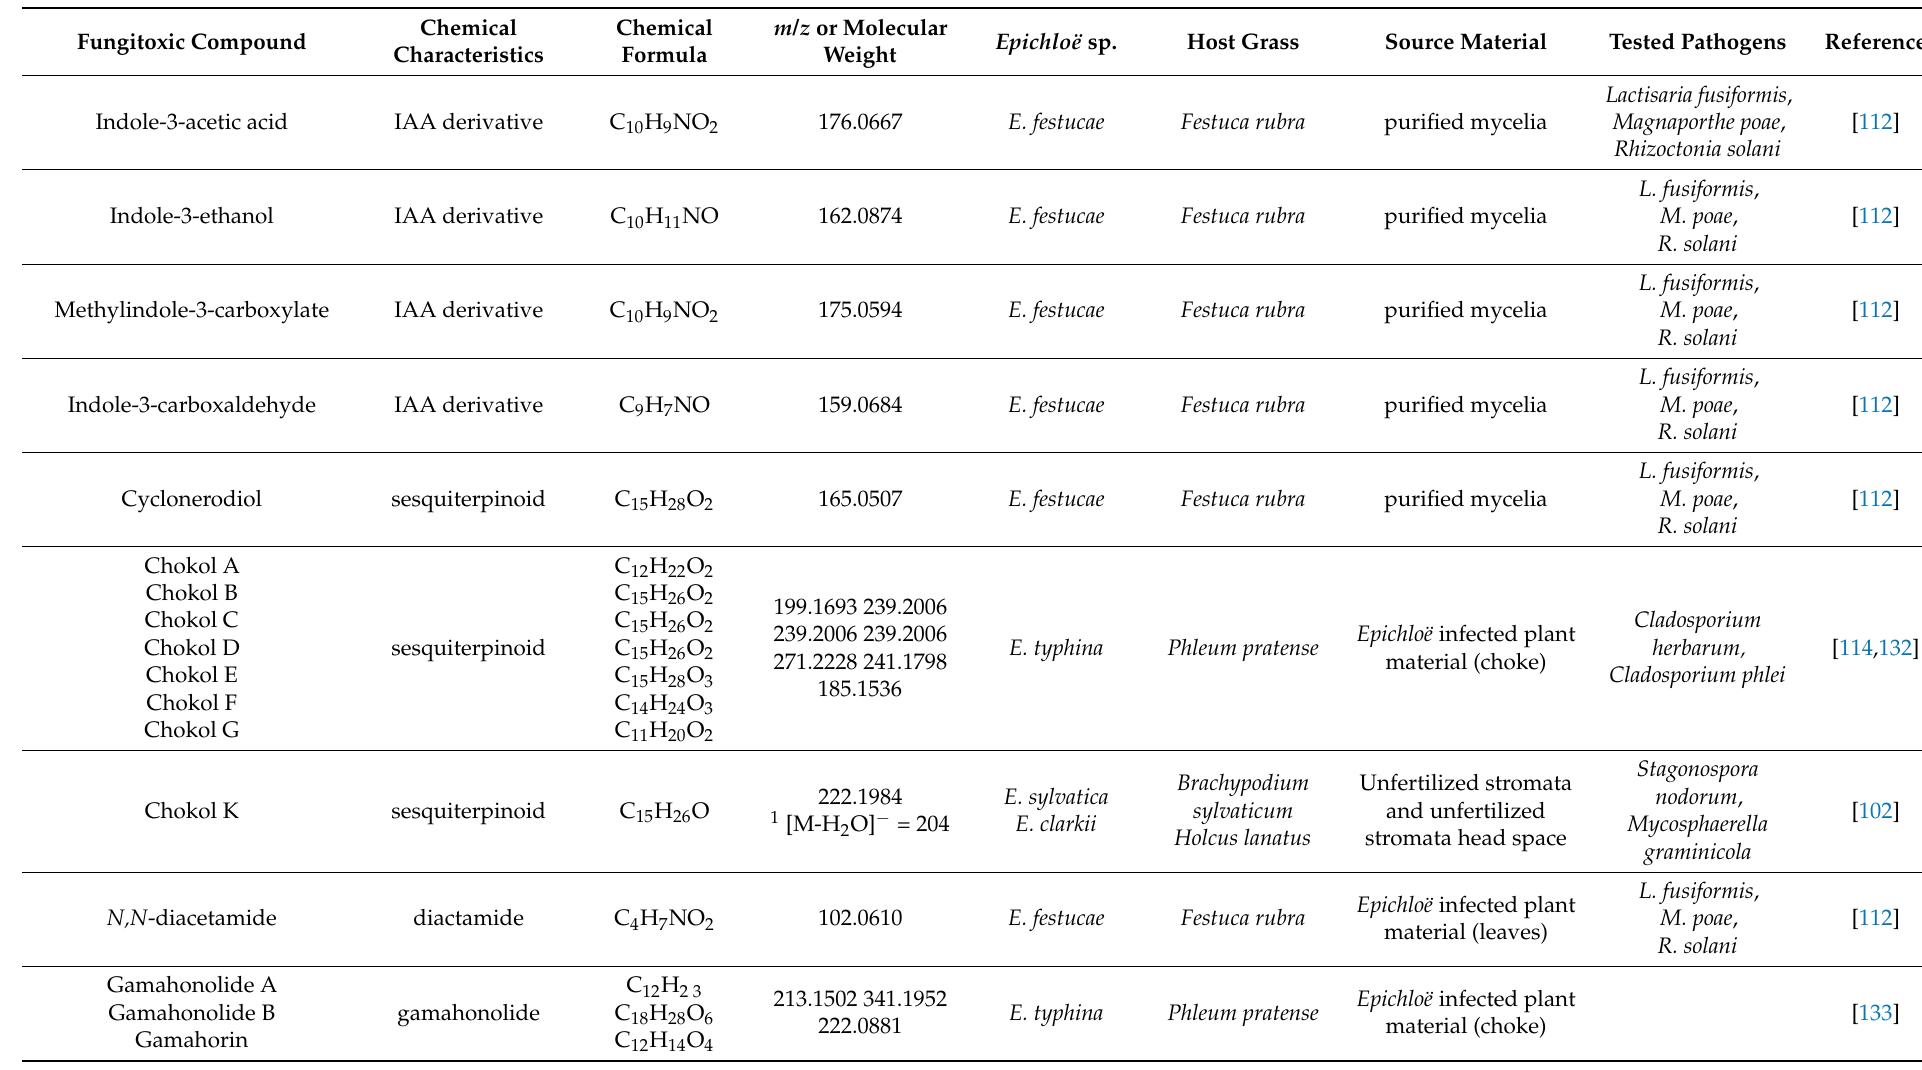
Table 3. Summary of fungitoxic compounds isolated from sexual Epichloë sp. and their